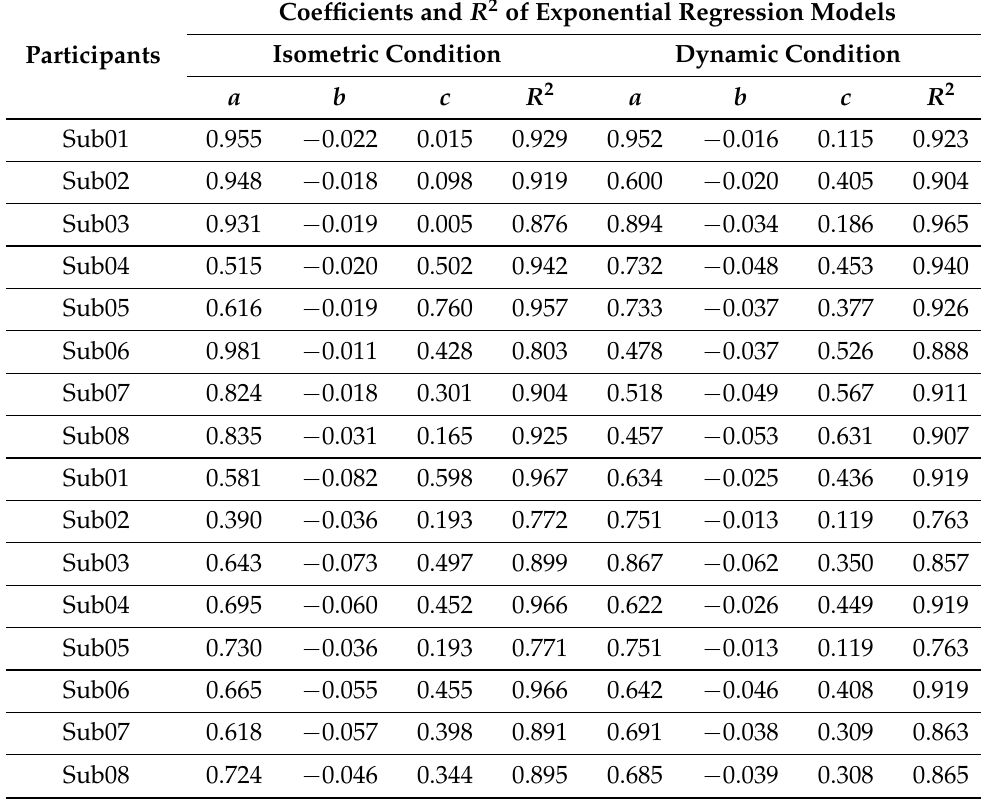
Table 2. Coefficients of exponential regression models ( y = a exp ( bx ) + c ) and R 2 values between each variable and the TA muscle contraction